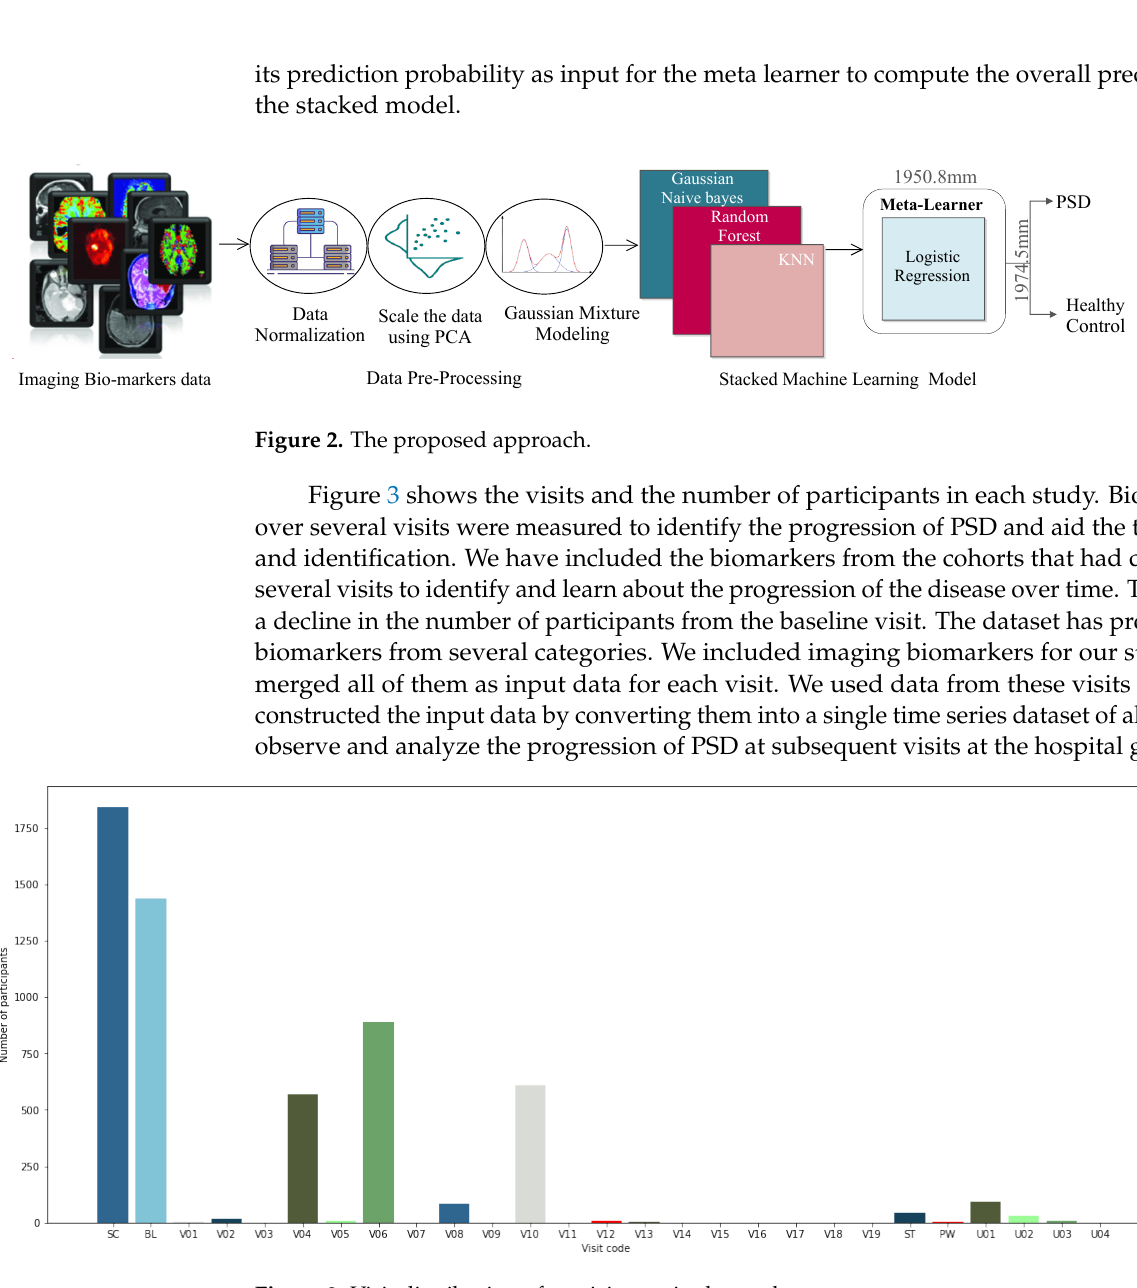
Figure 3. Visit distribution of participants in the